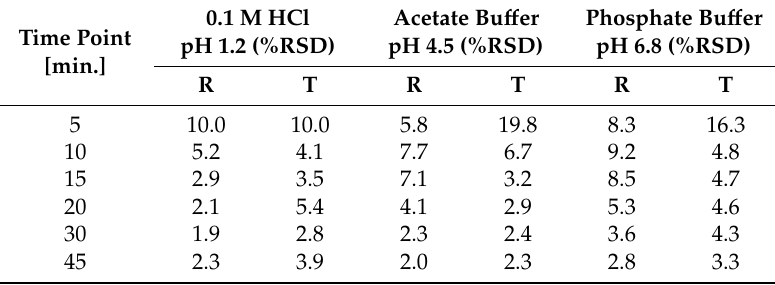
Table 5. The % RSD values for the in vitro release profiles of NF from in-house NF capsules (T, tested product) and Praxilene (R, reference product) in three di ff erent media 0.1 M HCl, acetate bu ff er, and phosphate bu ff er.